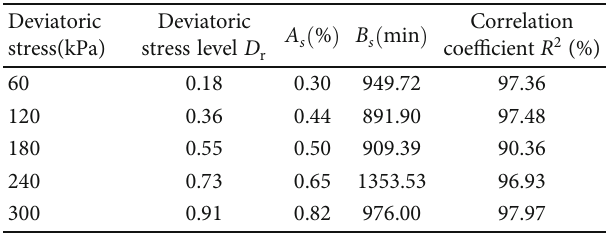
Table 8: Hyperbolic model parameters and correlation coe ffi cient R 2 of the triaxial creep test (reconstituted clay).